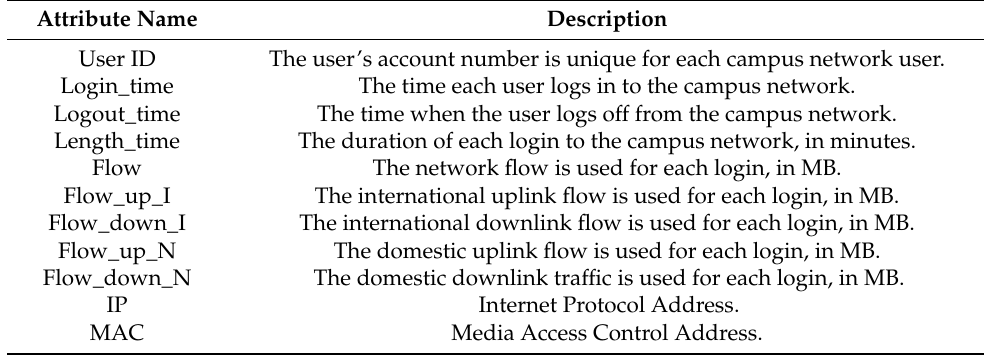
Table 2. Several important attributes and explanations of non-directional online